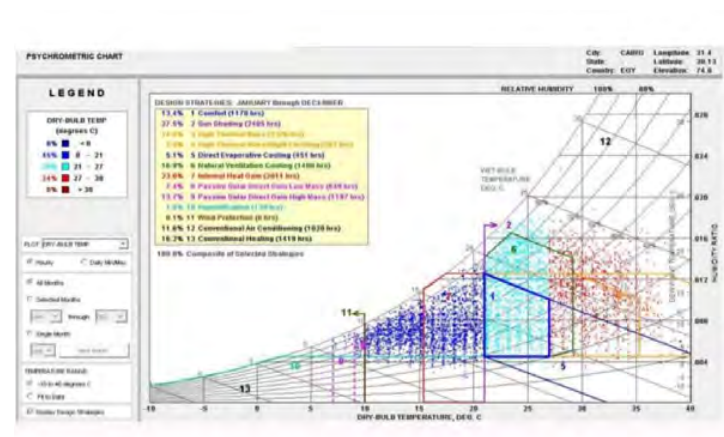
Figure 6. The thermal survey ofthe study area using the Climate 5.5 program (Beckman, 2017)